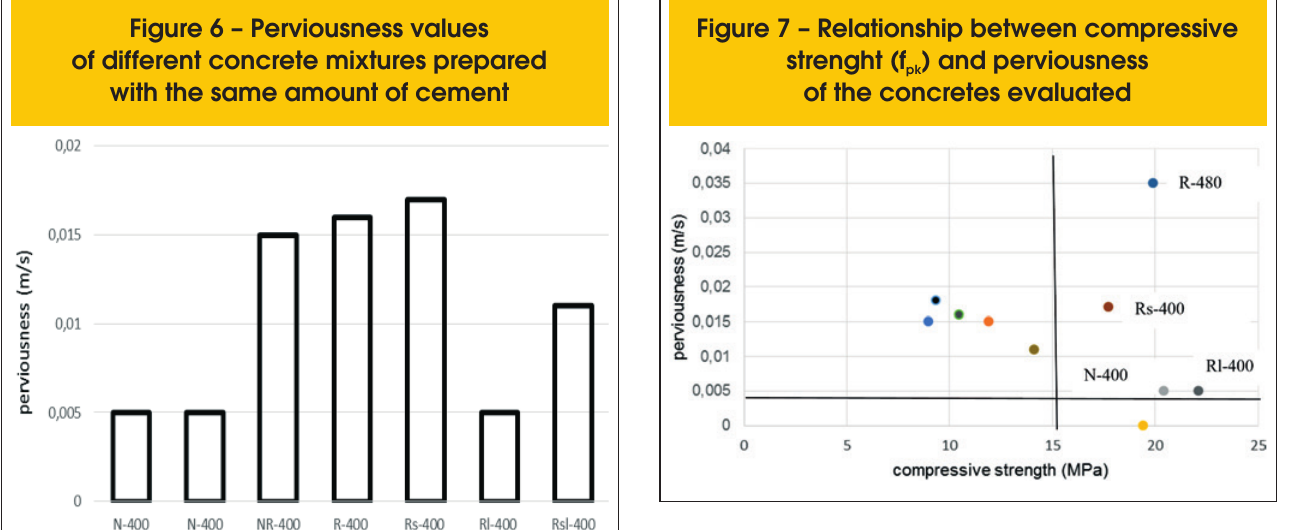
Figure 7 – Relationship between compressive strenght (f ) and perviousness pk of the concretes